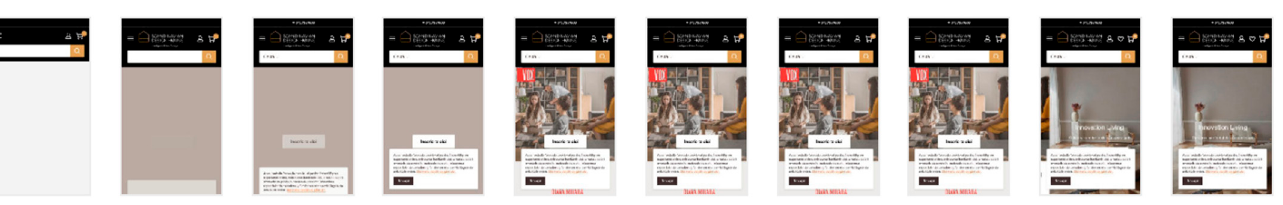
Figure 6. The chronology of content loading for sdhouse.ro.